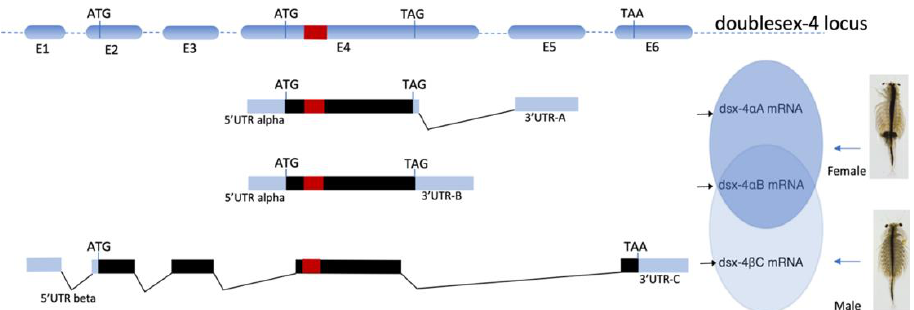
Figure 2. The alternative splicing model of the Af.dsx-4 locus in A. franciscana . E1 to E6 stand for six exons on the DNA scaffold containing the Af.dsx-4 locus. The red bar indicates the location of the DM domain. The black bar is the open reading frame of Af.dsx-4, starting at ATG and stopping at TAG or TAA. The dsx- 4αA (Af.dsx F ) is female-specific splicing, while the dsx- 4βC (Af.dsx M ) is male-specific splicing. The dsx- 4αB (Af.dsx 4 ) is present in males and females.